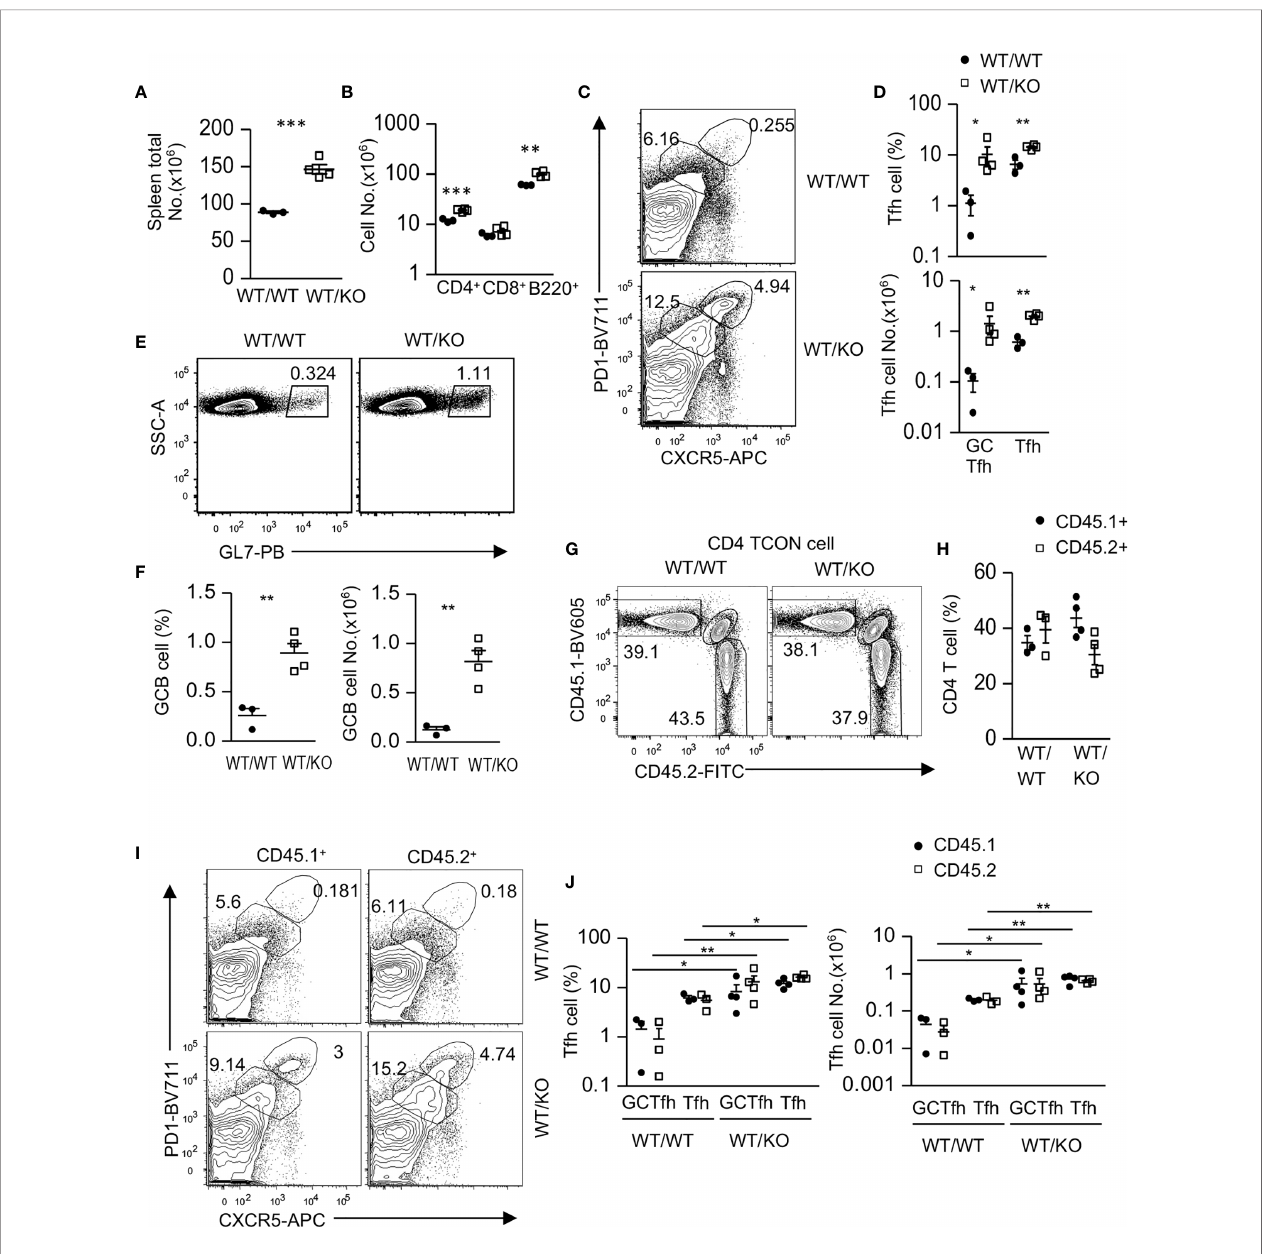
FIGURE 2 | Intrinsic and extrinsic control of Tfh cell differentiation by Tsc1. CD45.1 + CD45.2 + WT recipient mice were lethally irradiated (1,000 g ) and intravenously injected with a mixture of BM cells of either CD45.1 + WT and CD45.2 + WT (WT/WT) or CD45.1 + WT and CD45.2 + Tsc1 f/f -Cd4Cre (WT/KO) BM cells at 1:1 ratio. Splenocytes in recipient mice were analyzed 6 – 8 weeks later. (A) Total spleen cell numbers. (B) Total CD4 and CD8 T cell and B cell numbers. (C) Representative contour-plots of CXCR5 and PD1 staining in gated CD4 + TCR b + Foxp3 - T-cells. (D) Scatterplots represent mean ± SEM of GC-Tfh and Tfh cell percentages and numbers. (E) Representative dot-plots show GL7 staining in gated CD93 - B220 + B cells. (F) Scatterplots represent mean ± SEM of GC-B cell percentages and numbers. (G) Representative contour-plots of CD45.1 and CD45.2 staining in gated CD4 + TCR b + Foxp3 - T (Tcon) cells. (H) Scatterplots show CD45.1 + CD45.2 - and CD45.1 - CD45.2 + CD4 T cell percentages. (I) Representative contour-plots of CXCR5 and PD1 staining in gated CD45.1 + CD45.2 - and CD45.1 - CD45.2 + CD4 + TCR b + Foxp3 - T-cells. (J) Scatterplots represent mean ± SEM of CD45.1 + CD45.2 - and CD45.1 - CD45.2 + GC-Tfh and Tfh cell percentages and numbers. Data represent or are pooled from three experiments. * p < 0.05; ** p < 0.01, *** p < 0.001 determined by an unpaired two-tailed Student t